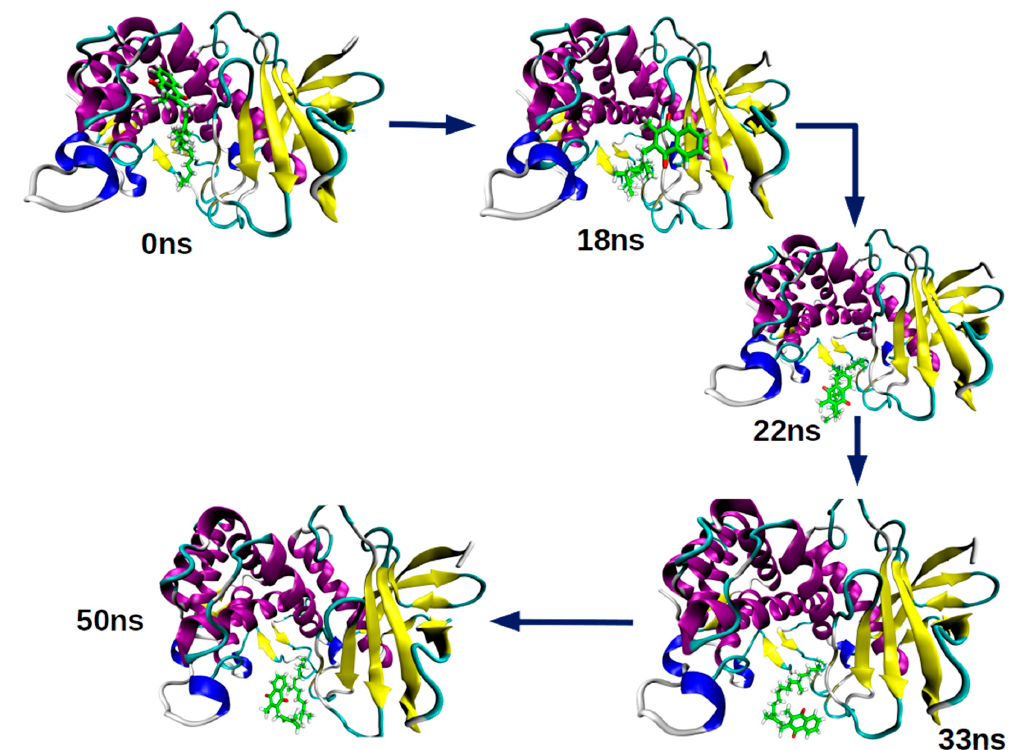
Figure 7. The Lig1022-5DPF complex’s conformational changes during the molecular dynamics simulation time (50 ns).